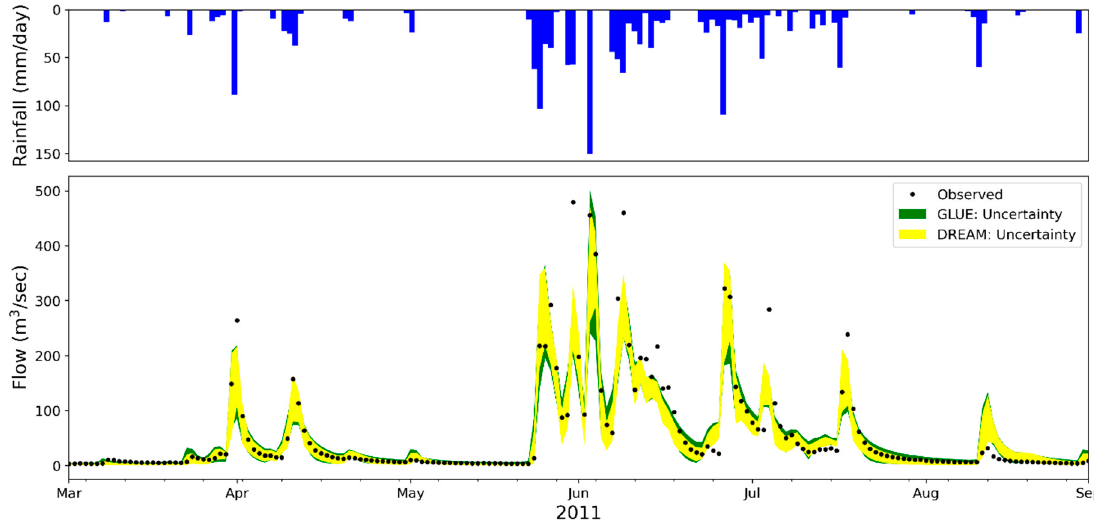
Figure 5. Uncertainty ranges of 95% simulations derived from the GLUE and DREAM approaches using the tank model with observed discharges ( · ) and areal averaged precipitation by the Thiessen polygon network at Station 1002640.